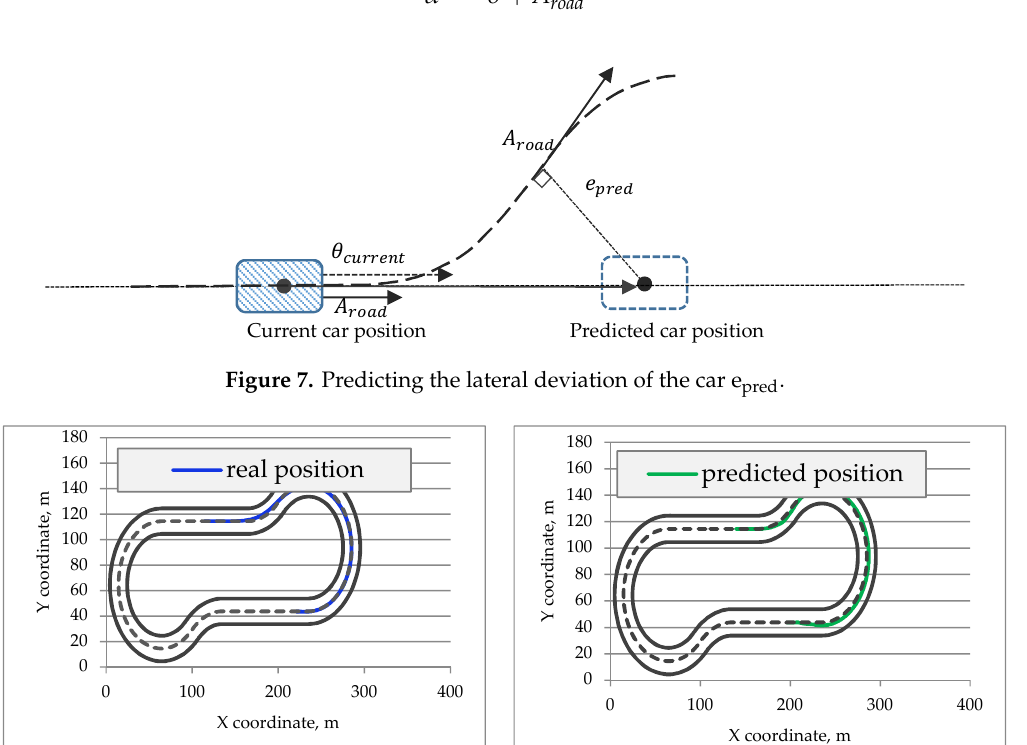
Figure 7 . Predicting the lateral deviation of the car e pred .